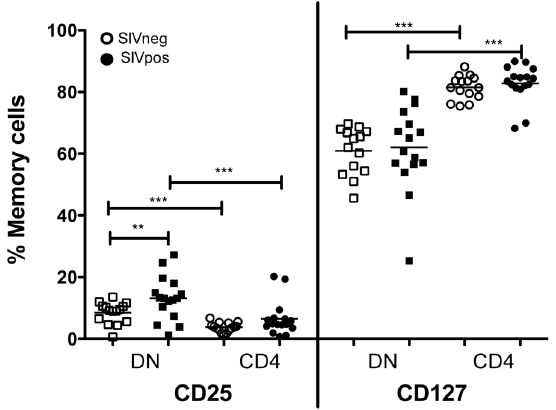
Figure 9. Flow cytometric analysis of homeostatic cytokine receptor expression of DN and CD4 T cells. Expression of IL2 receptor (CD25) and IL7 receptor (CD127) was assessed in memory population (CD95 + ) of DN and CD4 T cells from 15 uninfected (open symbols) and 15 SIV infected (filled symbols) mangabeys. CD25 expression was elevated in DN T cells from SIV infected mangabeys compared to uninfected mangabeys. In addition, CD25 expression was higher in DN T cells compared to CD4 T cells in a paired comparison. CD127 expression was higher in CD4 in comparison to DN T cells and these levels were not impacted following SIV